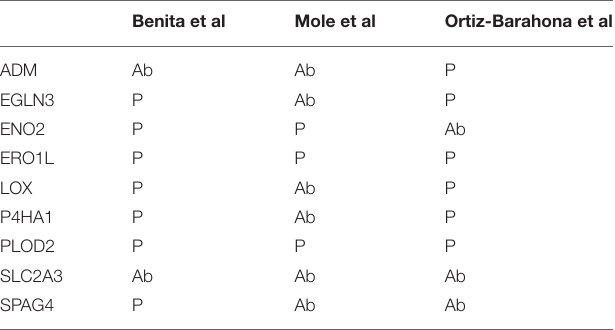
TABLE 2 | Enlist the presence (P) or absence (Ab) of the core hypoxic genes in the three studies on HIF1A target identification. Benita et